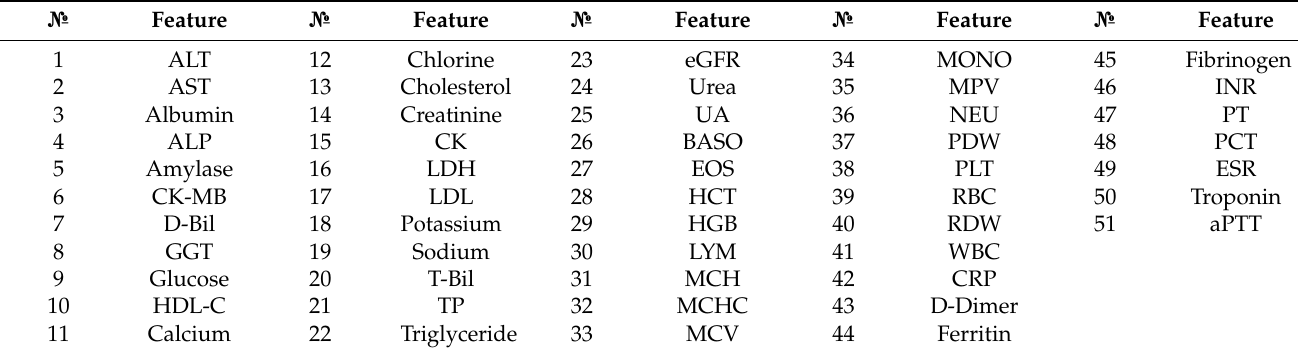
Table 2. Feature numbering for SARS-CoV-2-RBV2